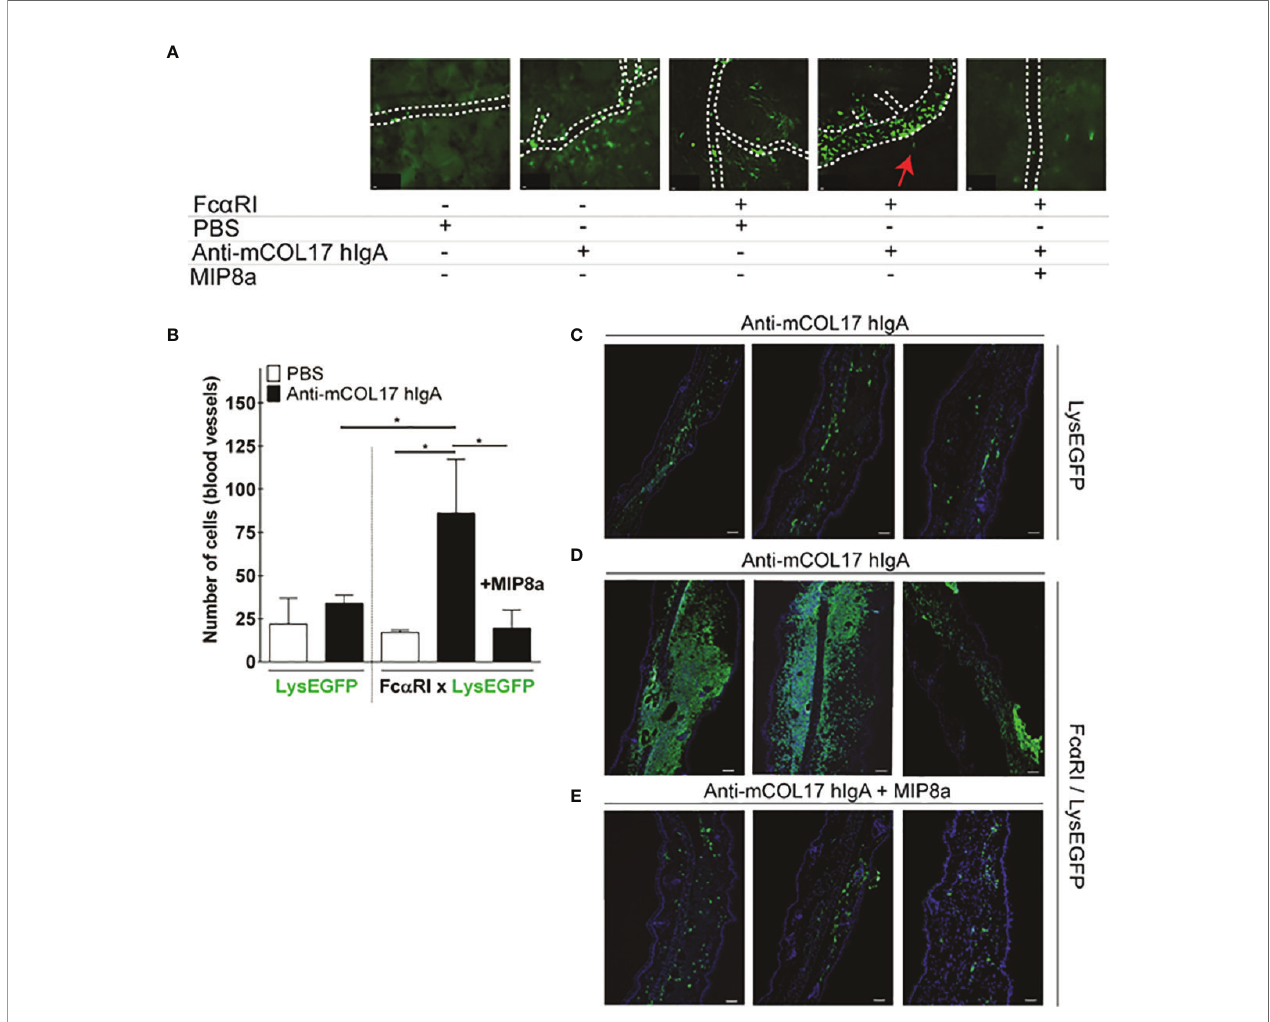
FIGURE 2 | Anti-mCOL17 hlgA antibodies induce Fc a RI-dependent neutrophil recruitment. (A) Still frames from intravital imaging movies, 48 hours after injection of PBS ( fi rst panel) or anti-mCOL17 hlgA (second panel) in ears of LysEGFP mice. Ears of Fc a RI/LysEGFP mice were injected with PBS (third panel), anti-mCOL17 hlgA (fourth panel) or anti-mCOL17 hlgA in combination with systematic treatment with Fc a RI blocking mAb MIP8a ( fi fth panel). Red arrowheah indicates neutrophil extravasation (see also Supplementary Videos 1 and 2 ). Scale bars: 10 m m. (B) Quanti fi cation of neutrophil numbers in contact with blood vessels in intravital imaging movies. n = 3 per group. (C – E) Cryosection of ears of (C) LysEGFP mice injected with anti-mCOL17 hlgA, (D) Fc a RI/LysEGFP mice injected with anti- mCOL17 hlgA without or (E) with treatment with anti-Fc a RI mAb MIP8a. Three examples per group are shown. Cryosections were stained with the neutrophil marker GR-1 (green) and DAPI (DNA; blue). Scale bars: 75 m m. Data are presented as mean ± SD. ANOVA; *p <